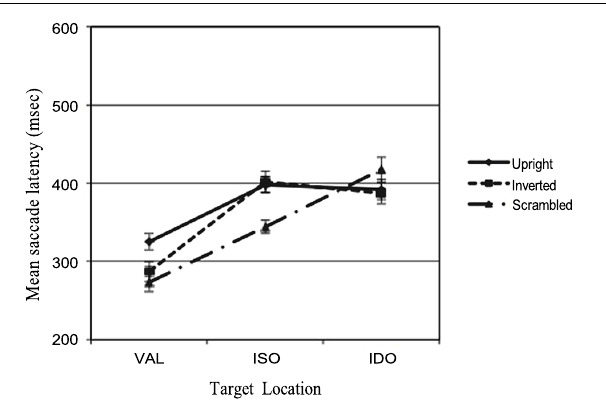
FIGURE 3 |Adults’ latencies related to the three different target locations and the three types of stimuli presented (upright, inverted, and scrambled